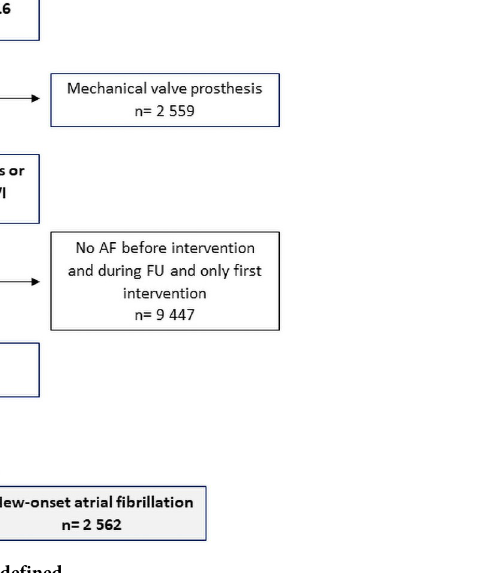
Fig 1. Flowchart of how the study cohort was